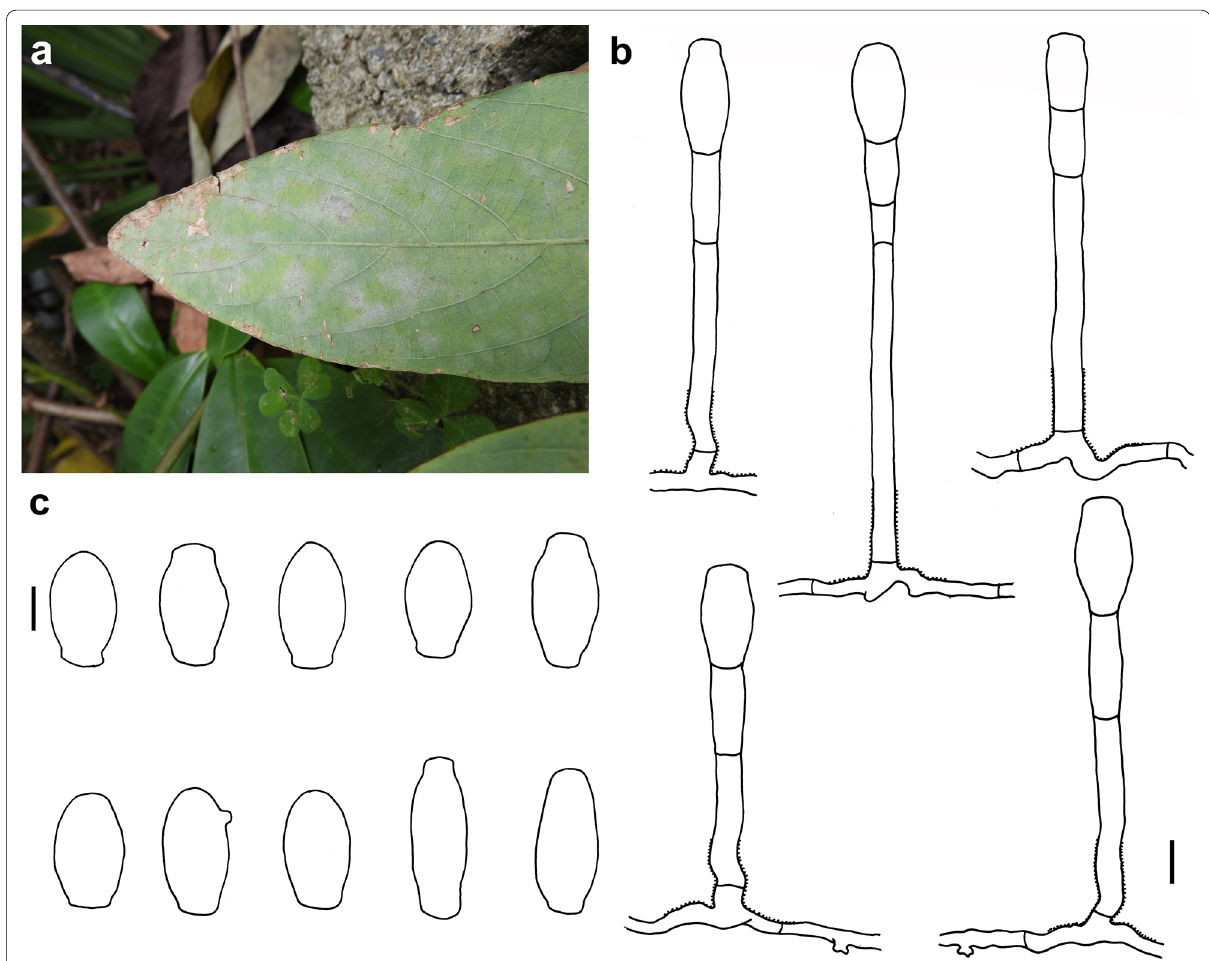
Fig. 7 Erysiphe lespedezae on Uraria crinita (AKII 0005). a . Powdery mildew symptoms on leaf. b Hyphae with lobed appressoria and conidiophores with curved foot cell. c Conidia. Scale bars 10 =